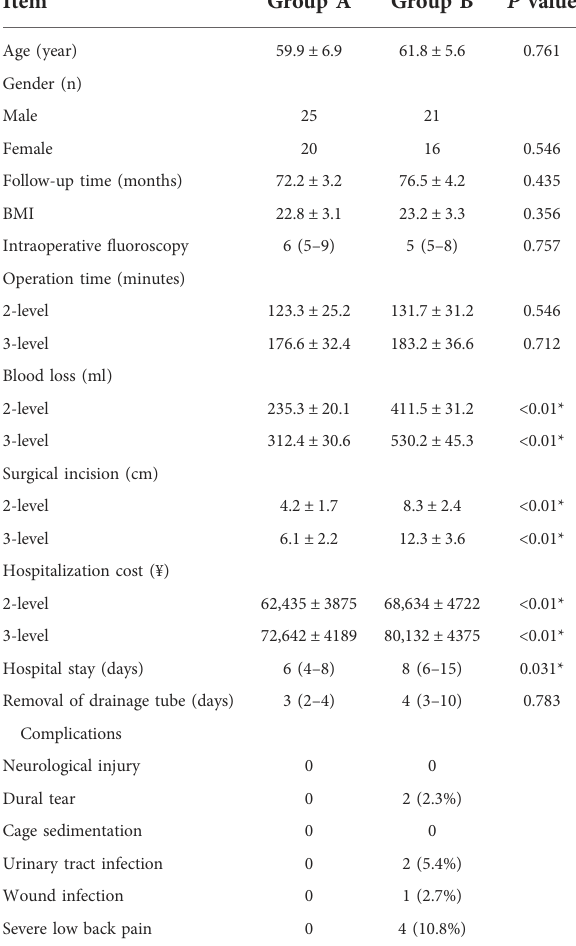
TABLE 2 Sample characteristics of two groups.